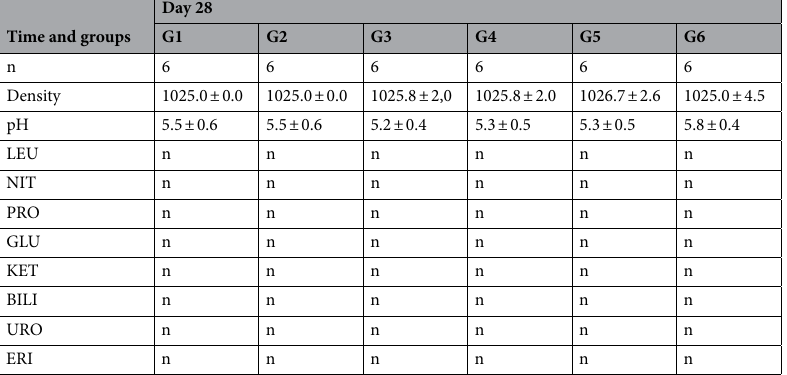
Table 2. Urine analytes in mice treated with ConvitVax or its components in repeated doses. The data is presented as the mean ± SEM of all mice in each group. Abbreviations: LEU leukocytes, NIT nitrites, PRO protein, GLU glucose, KET ketone bodies, BILI bilirubin, URO urobilinogen, ERI erythrocytes, n negative.